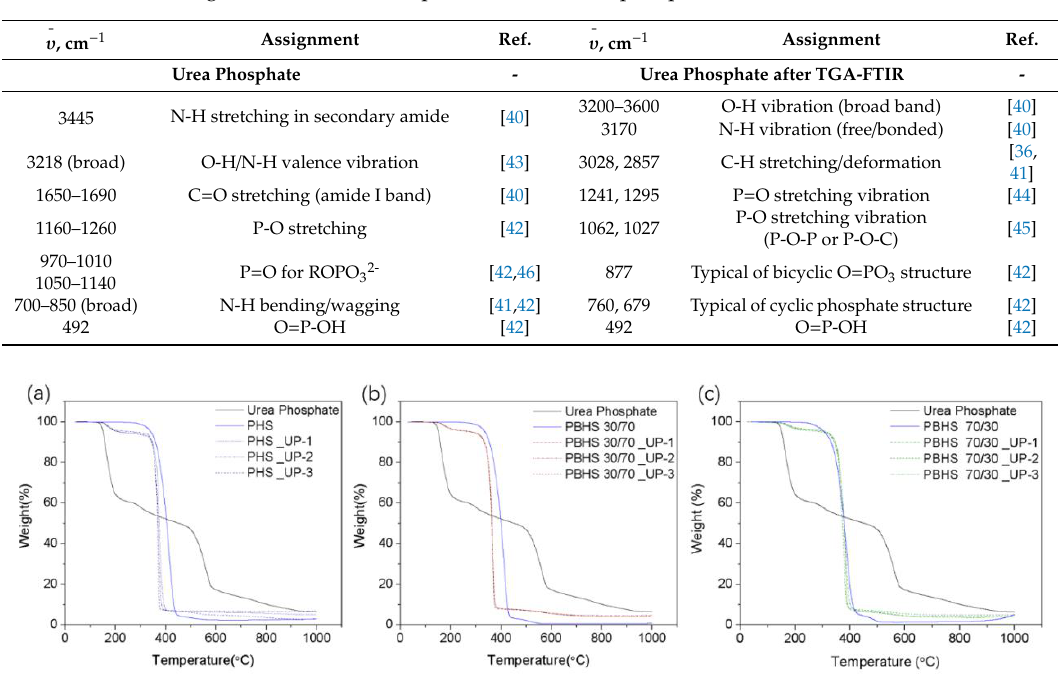
Table 2. Assignment of FTIR absorption bands of urea phosphate before and after TG-FTIR.